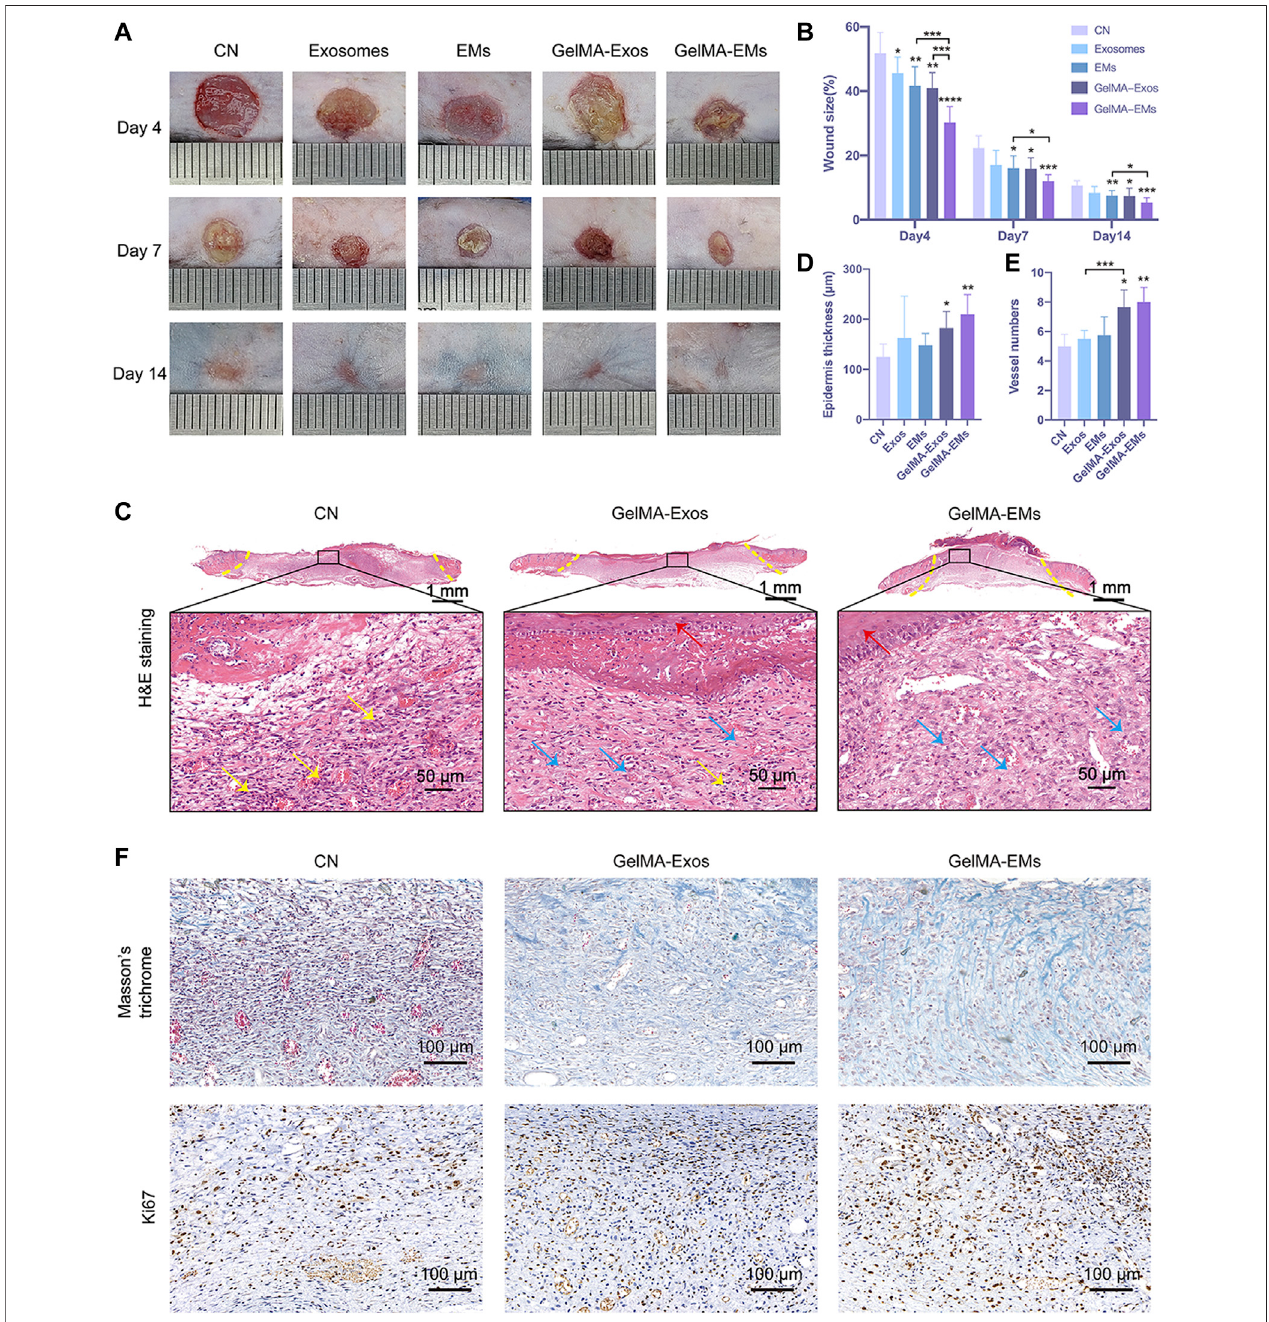
FIGURE 3 | The effect of hUMSC-derived exosome mimetics on skin wound healing in vivo . Representative images (A) and quanti fi cation (B) of full-thickness cutaneouswoundsizesshowed thatthehUMSC-derived exosome mimeticsloadedon GelMA could accelerate the woundhealing process. Thedata areshown asthe mean ± SD. The signi fi cant difference between the untreated and hydrogel-treated groups was analyzed by the t-test ( n = 6, * p < 0.05, ** p < 0.01, *** p < 0.001, **** p < 0.0001). Epidermis thickness (C) and vessel numbers (D) per random fi eld were analyzed by the t-test. ( n = 4, * p < 0.05, ** p < 0.01) H&E staining (E) of the wound sites is shown. The yellow dotted lines indicate the boundary of the wound sites. The blue arrows indicate granulation tissues. The yellow arrows indicate in fl ammatory neutrophils. The red arrows label the newly formed epidermis. (F) Masson ’ s trichrome staining and ki67 immunohistochemistry staining of wound sites.